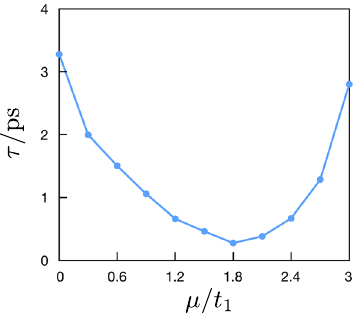
Fig. 7 Scattering time. Scattering time as a function of the chemical potential μ extracted from Eq. (3) being changed in such a way that ν remains constant. The coupling strength is fi xed to g / t